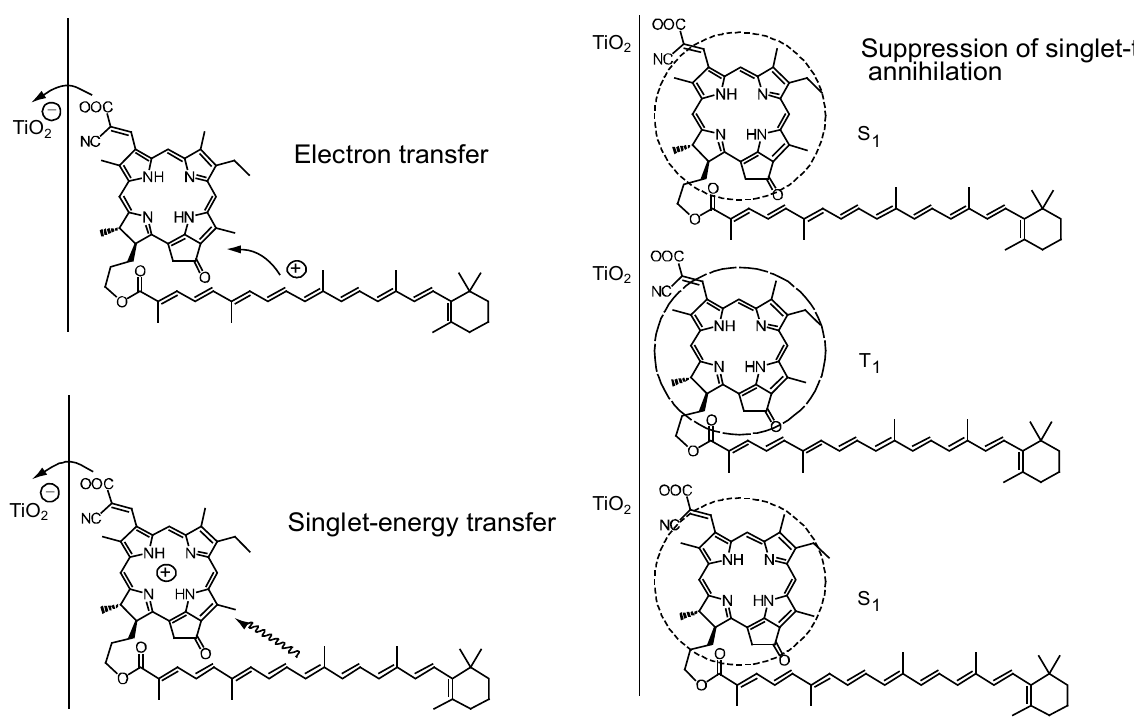
Figure 19. Mechanisms of the enhancement of photocurrent and conversion efficiency in the solar cell using the Phe–Car adduct sensitizer (reprinted from [9] with permission of